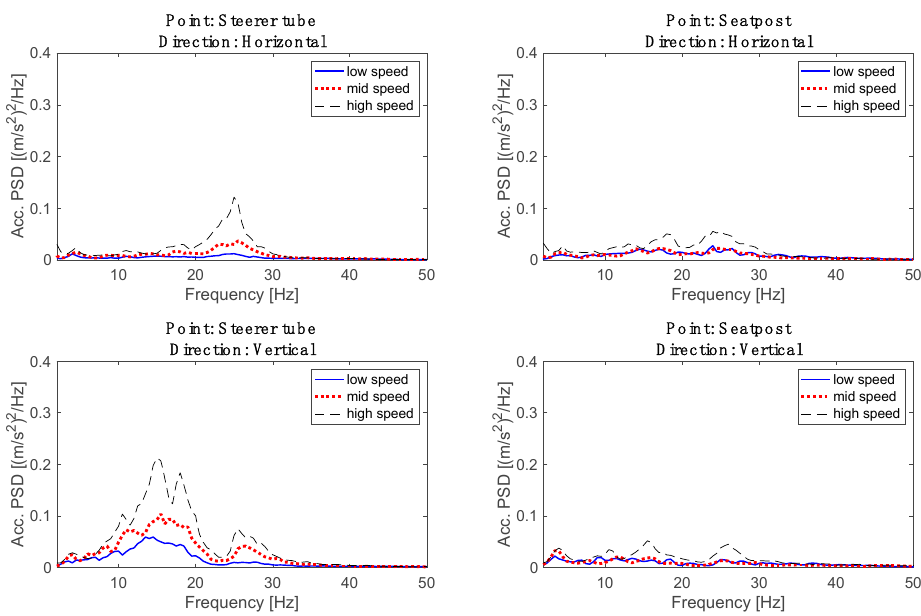
Figure 2. Acceleration PSDs of Bicycle A.